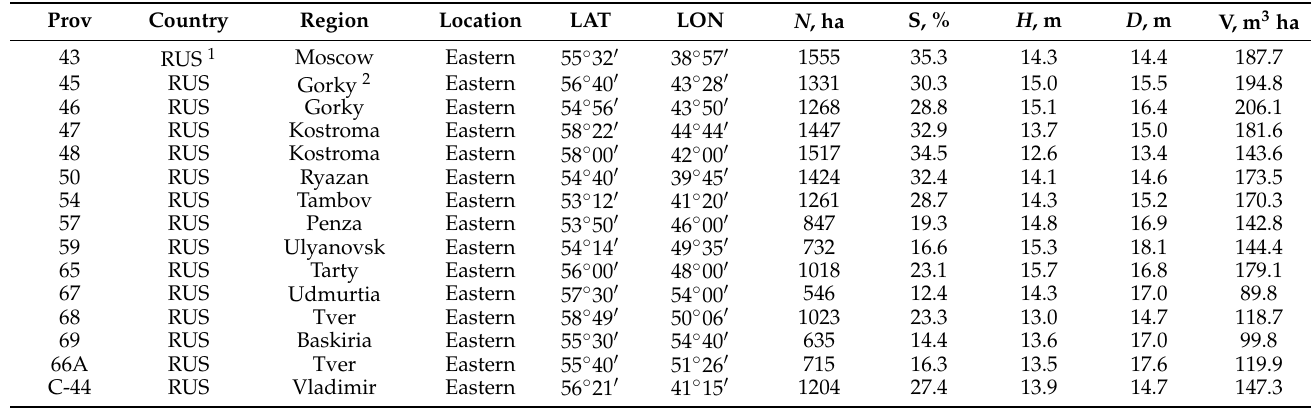
Table 1. The geographic data and locations of pine